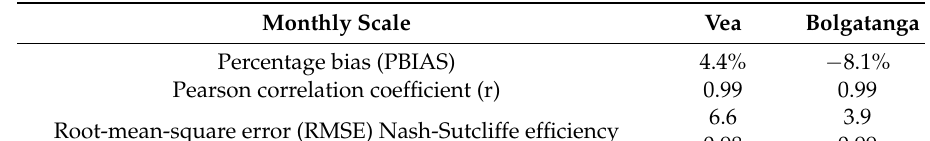
Figure 2. Performance evaluation of Climate Hazards Group InfraRed Precipitation with Station (CHIRPS) based on mean monthly distribution ( A , B ) and annual distribution ( C , D ) of rainfall from 1990 to 2016 for the Vea and Bolgatanga locations. Table 4. Mean monthly and annual scale statistical analysis of rainfall for the station and CHIRPS data from 1990 to 2016 in the catchment.